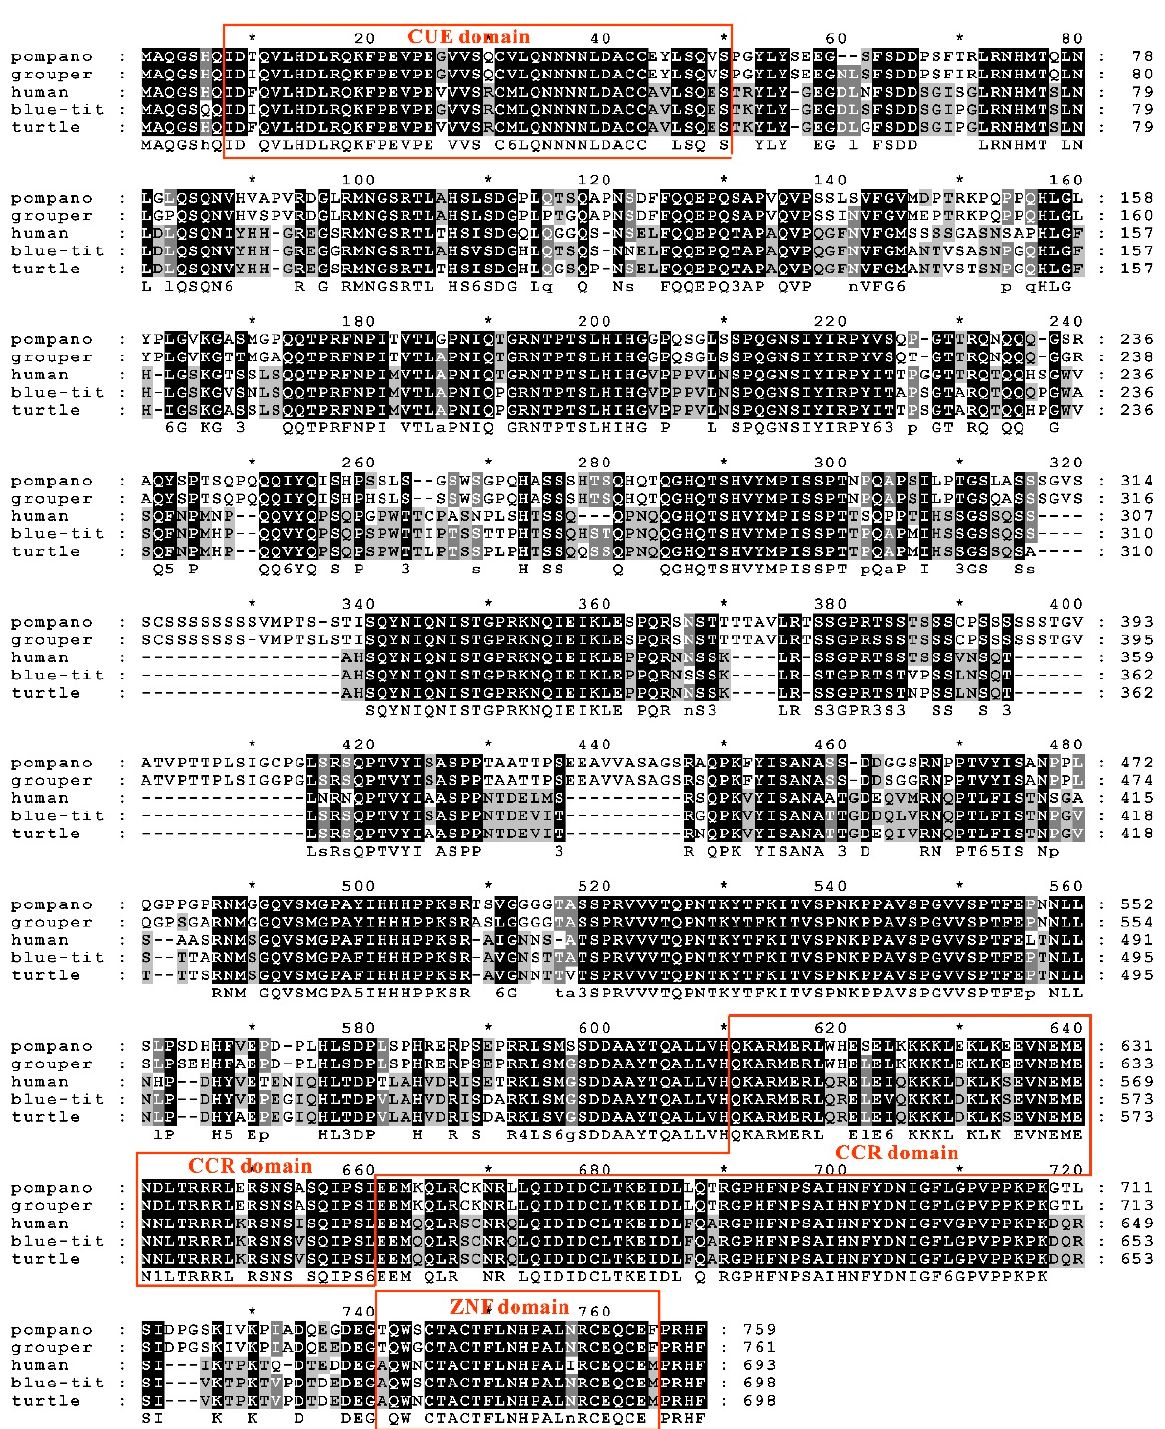
Figure 5. Nucleotide and deduced amino acid sequence of the trTAB2 gene ( A ) and its predicted domains ( B ). The start codon (atg) and stop codon (tga) are marked in pink. The CCR domain is marked in green, the ZnF domain is marked in cyan and the CUE domain is marked in red.